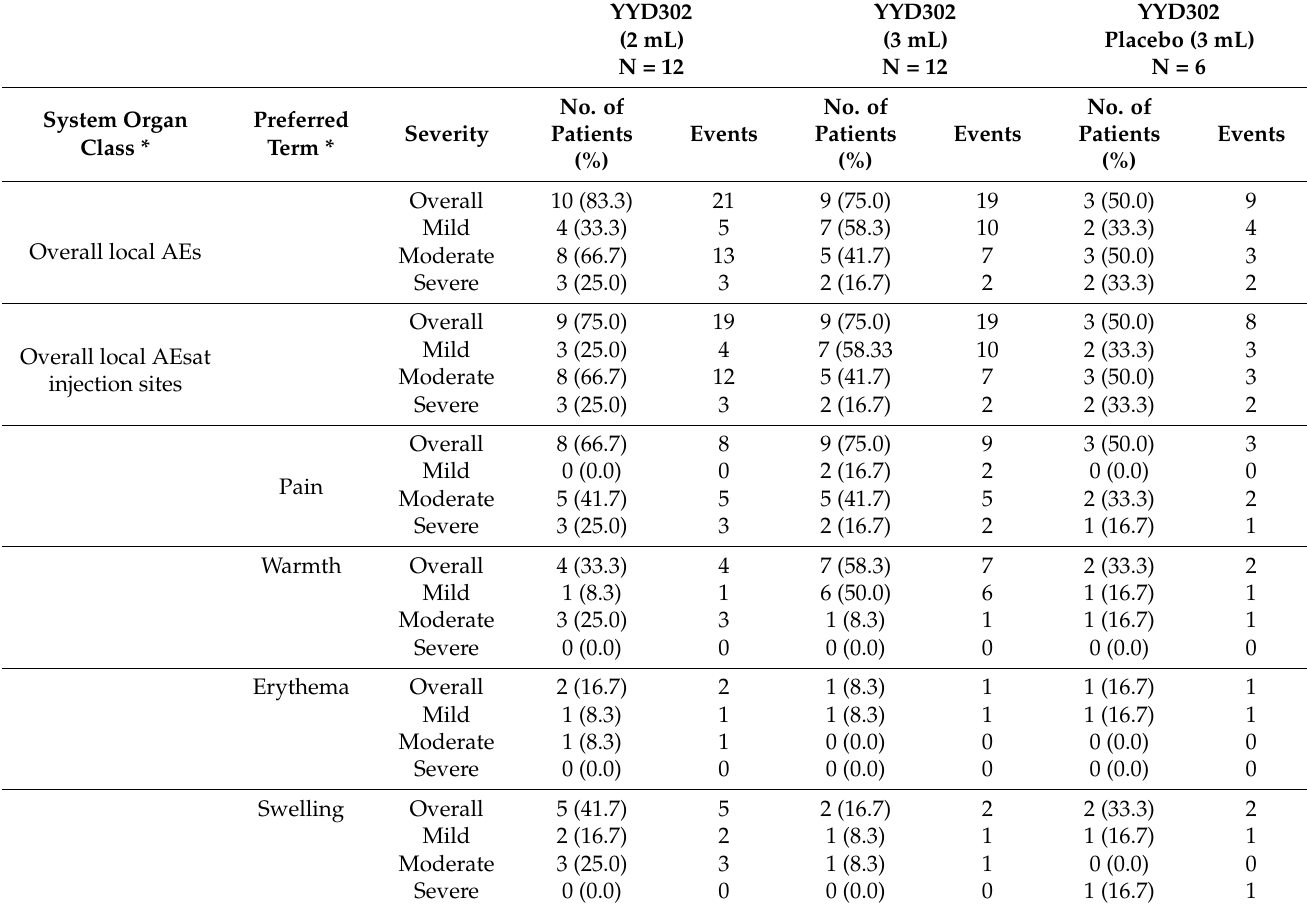
Table 5. Details of adverse events by severity